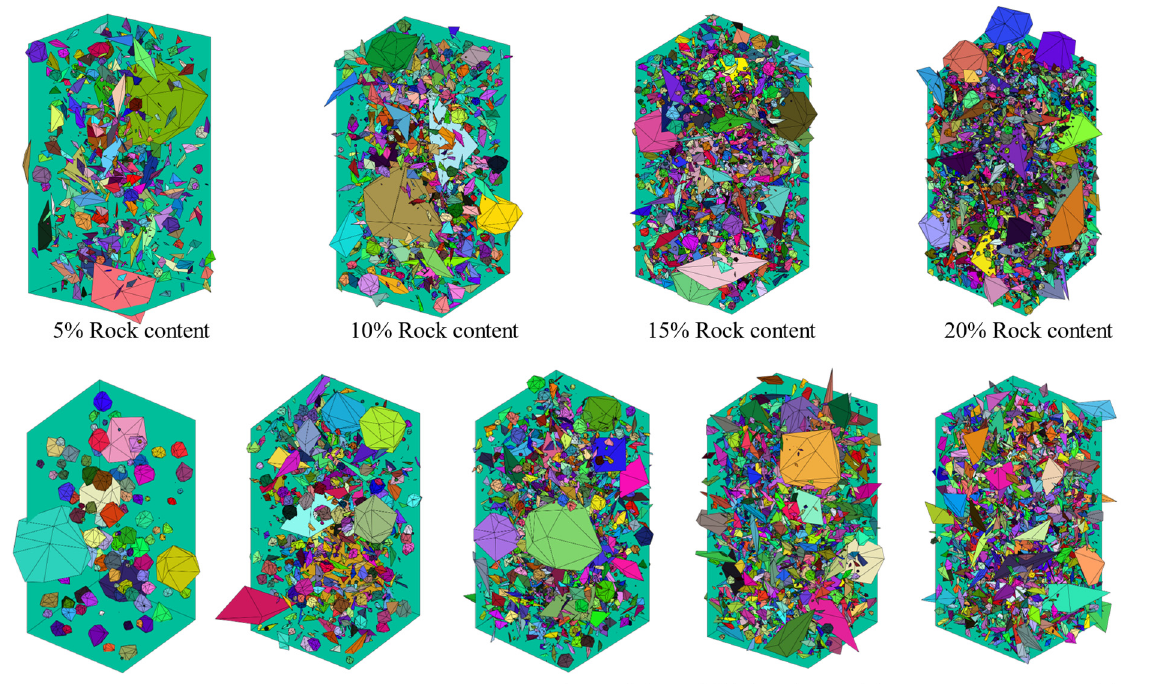
Figure 8. Examples of generated mesostructures with different rock contents and particle shapes.